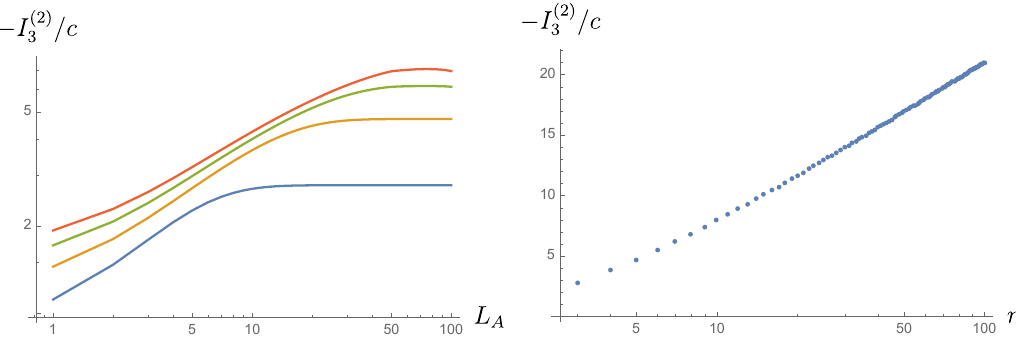
Figure 7 . (left) The dependence on subsystem size L A of the saturation value of TOMI for ( m; m +1) with m = 3 ; 5 ; 7 ; 9 from bottom to top. The saturation to a constant occurs around M f g L A =(cid:15) m 2 , before which, the growth is sublinear. (right) The saturation value in the scaling limit (cid:24) using (3.18) shows logarithmic scaling with m